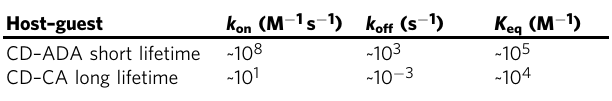
Table 1 The kinetic and thermodynamic constants for complexations between cyclodextrin and adamantane or cholic